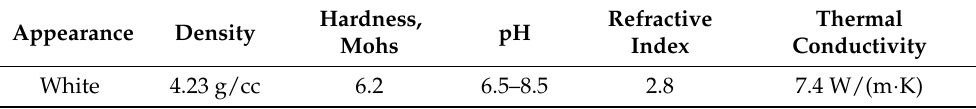
Table 1. The technical characteristics of rutile TiO 2 .